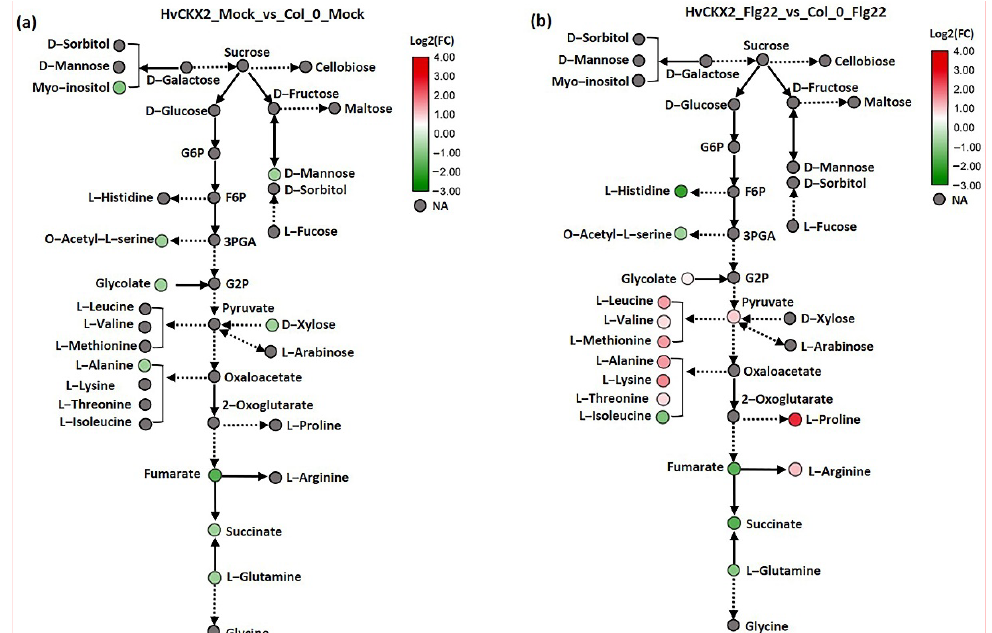
Figure 6. ( a , b ) Network-integrated visualization of altered metabolites in HvCKX2 plants treated without or with flg22 relative to the corresponding wild types. The coloured circles highlight CK pool-sensitive metabolites, according to the metabolome comparative analysis of HvCKX 2 and wild-type genotypes. Metabolites with no statistically significant changes are shown in grey (NA—not affected).